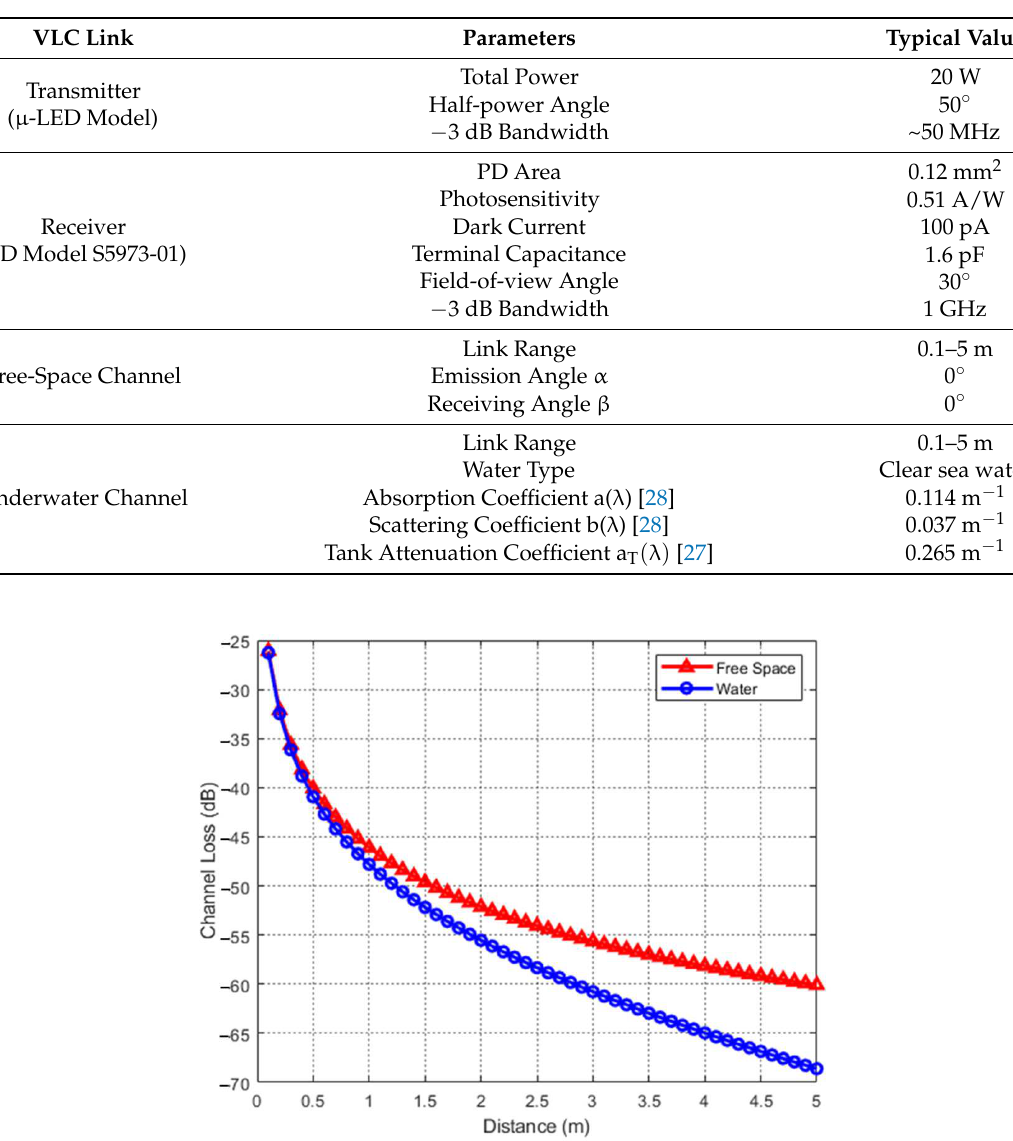
Table 1. Simulation parameters for the VLC link model.